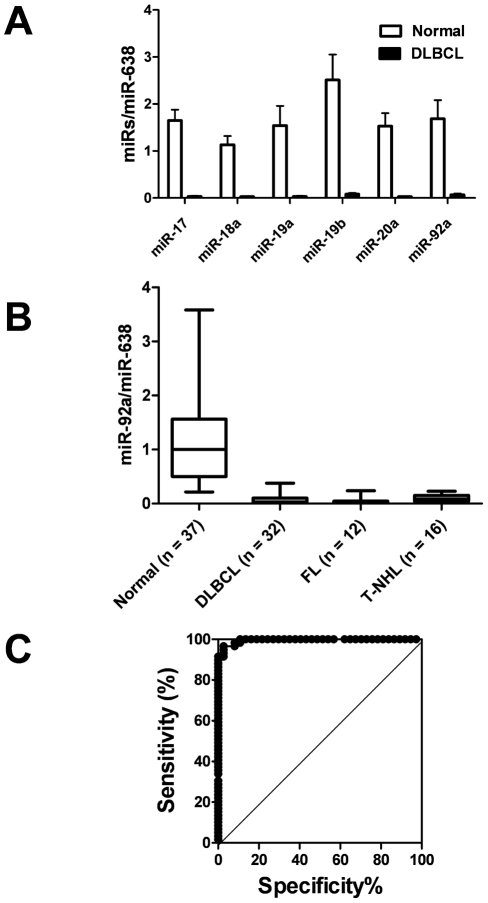
Plasma miR-92a expression level and ROC curve in patients with non-Hodgkin's lymphoma by quantitative real-time PCR.(A) Plasma miR-17-92a expression levels in normal subjects (open bars: Normal: n = 5) and diffuse large B-cell lymphoma (solid bars: DLBCL: n = 13), indicating that all of these miR-17-92a polycistronic miRs were remarkably decreased in plasma obtained from DLBCL patients. Boxes show 95 percentile confidence intervals and lines indicate the range of each miR values. (B) Plasma miR-92a value (miR-92a/miR-638) in healthy subjects, and in patients with diffuse large B-cell lymphoma, follicular lymphoma, and T-cell non-Hodgkin's lymphoma (T-NHL) at diagnosis. Boxes show 95 percentile confidence intervals; lines indicate the range of miR-92a values and also show significantly low levels of plasma miR-92a in various lymphomas, compared with healthy subjects (P<.0001). (C) ROC curve analysis using GraphPad Prism 5.0 software. The cut-off level of plasma miR-92a/miR-638 in all non-Hodgkin's lymphoma patients (n = 60) was 0.2165; the sensitivity was 91.85% (95% CI: 81.32% to 97.19%) and specificity was 97.3% (95% CI: 85.84% to 99.93%).